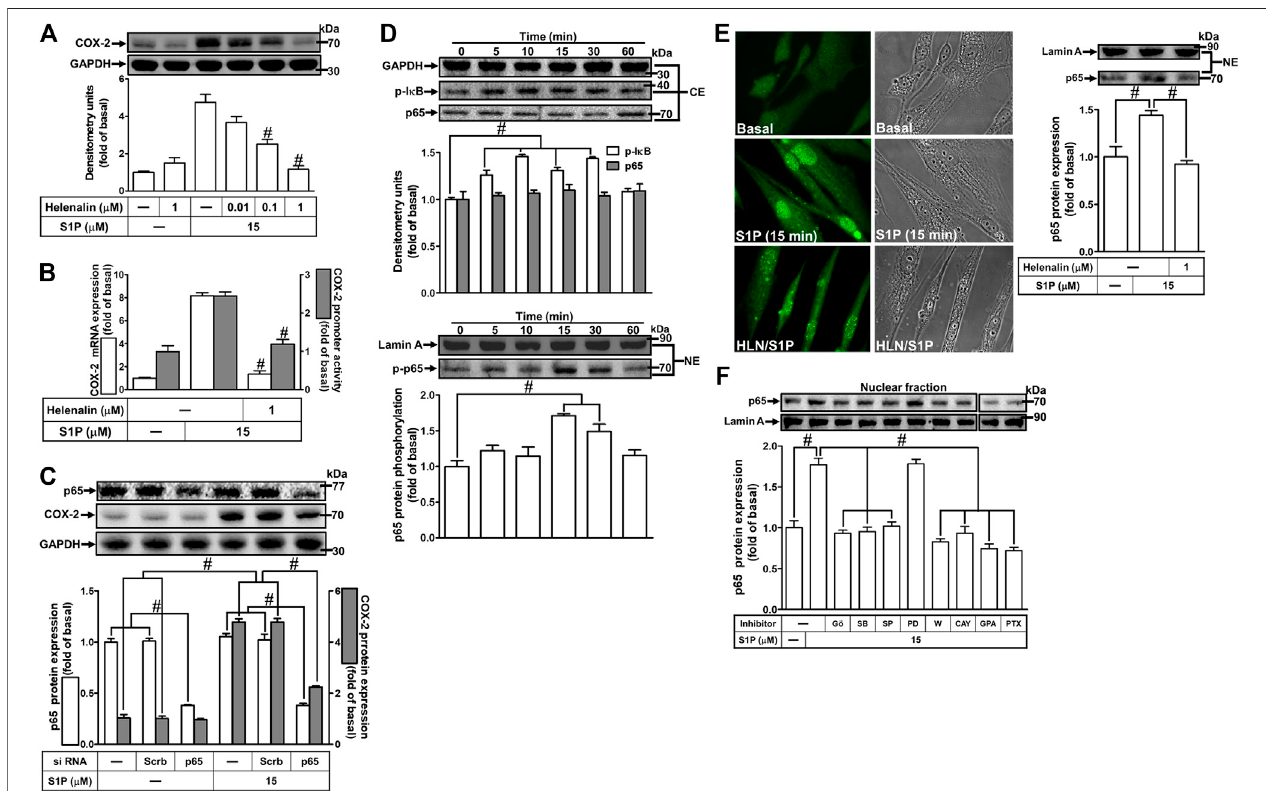
FIGURE 8 | NF- κ B isessential for S1P-induced COX-2 expression. (A) Cells were pretreated with helenalin for 1 h and then incubated with 15 μ M S1P for 8 h. (B) Cells were transfected without or with COX-2 promoter-luciferase reporter gene, pretreated without or with helenalin (1 μ M) for 1 h, and then incubated with 15 μ M S1P for 4 h (mRNA) or 1 h (promoter).The levels of COX-2 protein, mRNA expression, and promoter activity were determined by Western blot, real time-PCR, and promoter assay,respectively. (C) CellsweretransfectedwithsiRNAofp65andthenexposedtoS1Pfor8 h. (D) CellswereincubatedwithS1P(15 μ M)fortheindicatedtime intervals. (E) Cells were treated with S1P (15 μ M) for 15 min in the absence or presence of helenalin (1 μ M). (D,E) The nuclear and cytosol fractions were prepared and analyzed by Western blot. The p65 NF- κ B translocation by S1P was also determined by immuno fl uorescent staining as described in Materials and Methods . (F) To determine which S1PRsubtypes, Gior Gq protein, and MAPKs involvedin S1P-stimulatedthe nuclear localization ofp65NF- κ B, cellswere incubated with S1P(15 μ M) for15 minintheabsenceorpresenceofGö6976 (Gö,10 μ M),SB202190(SB,30 μ M),SP600125(SP,10 μ M),PD98059(PD,10 μ M),W123(W,10 μ M),CAY(10 μ M), GPA2A (GPA, 10 μ M), or PTX (100 ng/ml), and the nuclear fraction was analyzed by Western blot. To fi t the construct of data layout, the data were rearranged from the samegel with the exception of non-related inhibitors and disclosed by the insertion of white spaces rearranged from the originalcapture. Dataare expressed as mean ± SEM of three individual experiments (n (cid:2) 3). # p < 0.05, as compared with the cells treated with S1P